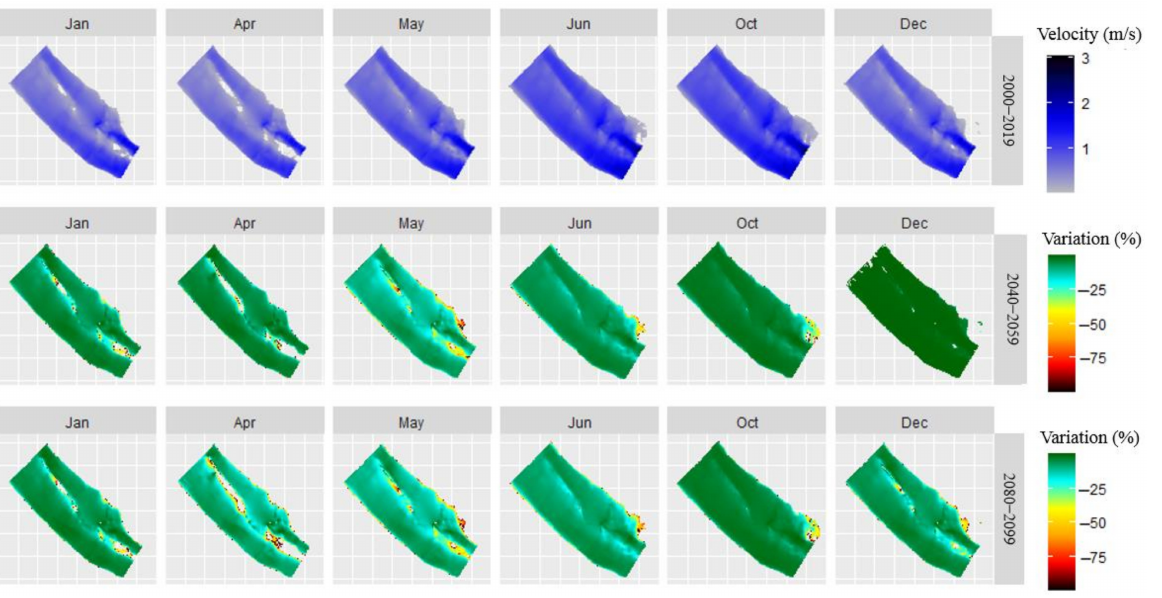
Figure 10. Variation in the average monthly flow velocity for the CCS, concerning the period 2000–2019.